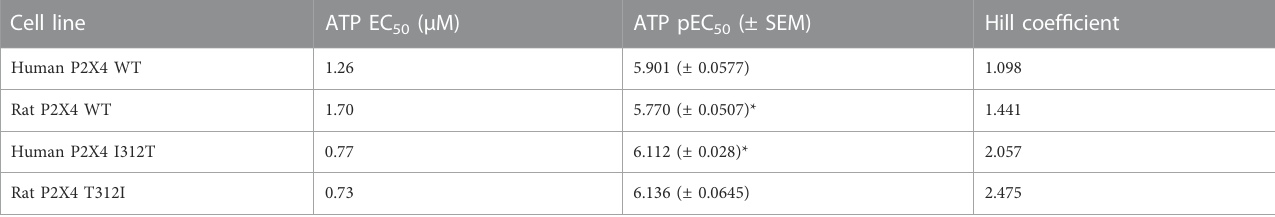
TABLE 2 ATP EC 50 , pEC 50, and Hill Coef fi cient values for wild type (WT) and mutant rat and human P2X4 receptors. SEM, standard error of the mean. *indicates a statistically signi fi cant difference between rat P2X4 WT and human P2X4 I312T ( p ≤